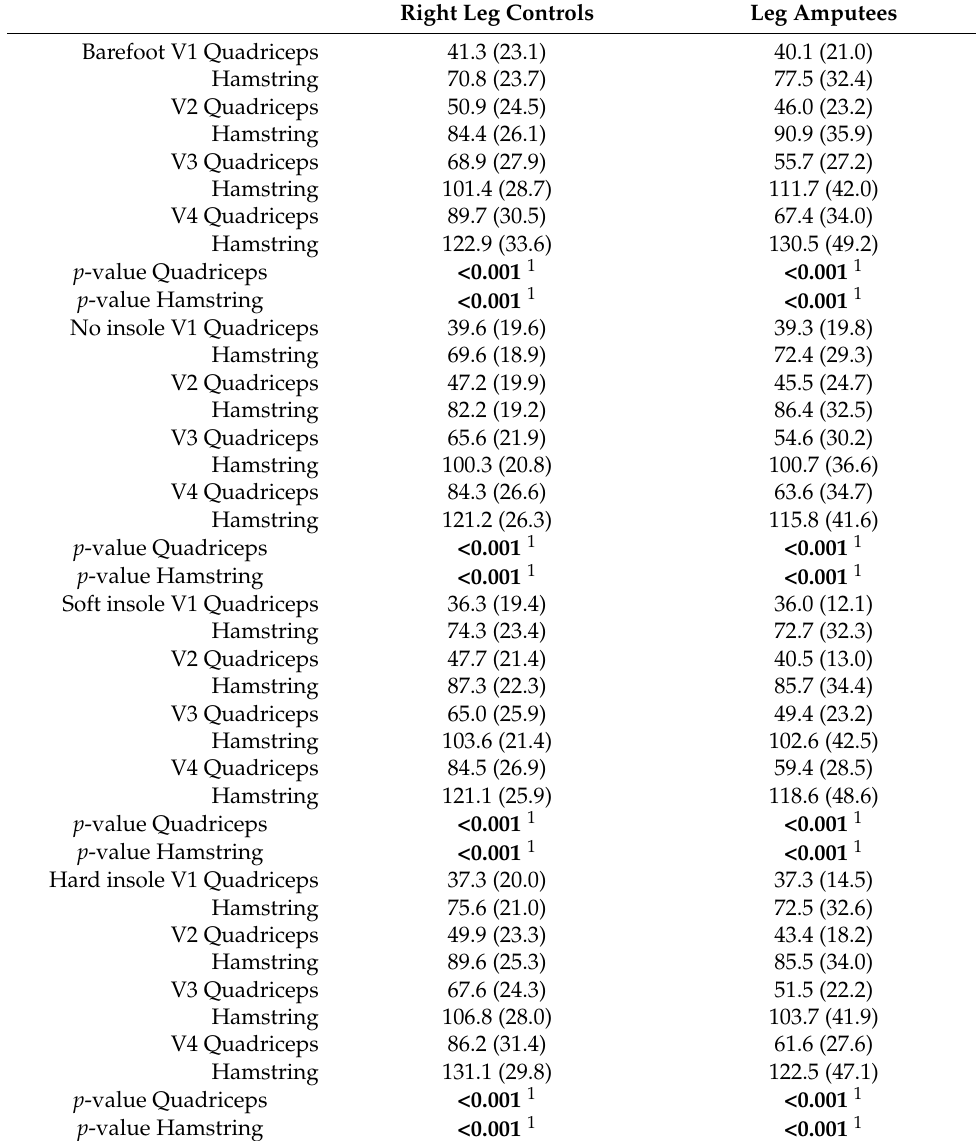
Table 4. EMG according to situation and leg: control right versus amputees. Influence of